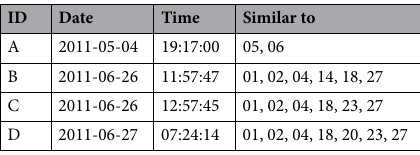
Table 1. Detected events by the proposed algorithm.